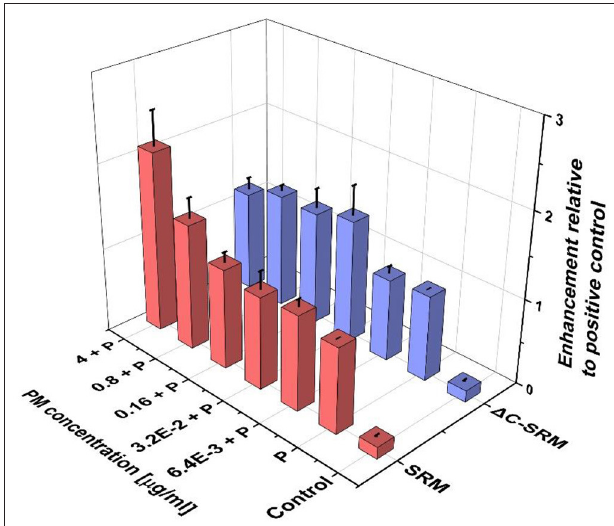
FIGURE 2 | The reactive oxygen species (ROS) production in A549 cells pretreated with particulate matter (PM) suspensions for 24h and subsequently exposed to pyocyanin (P) was evaluated using cyto-ID Hypoxia/Oxidative stress detection kit (exposure method